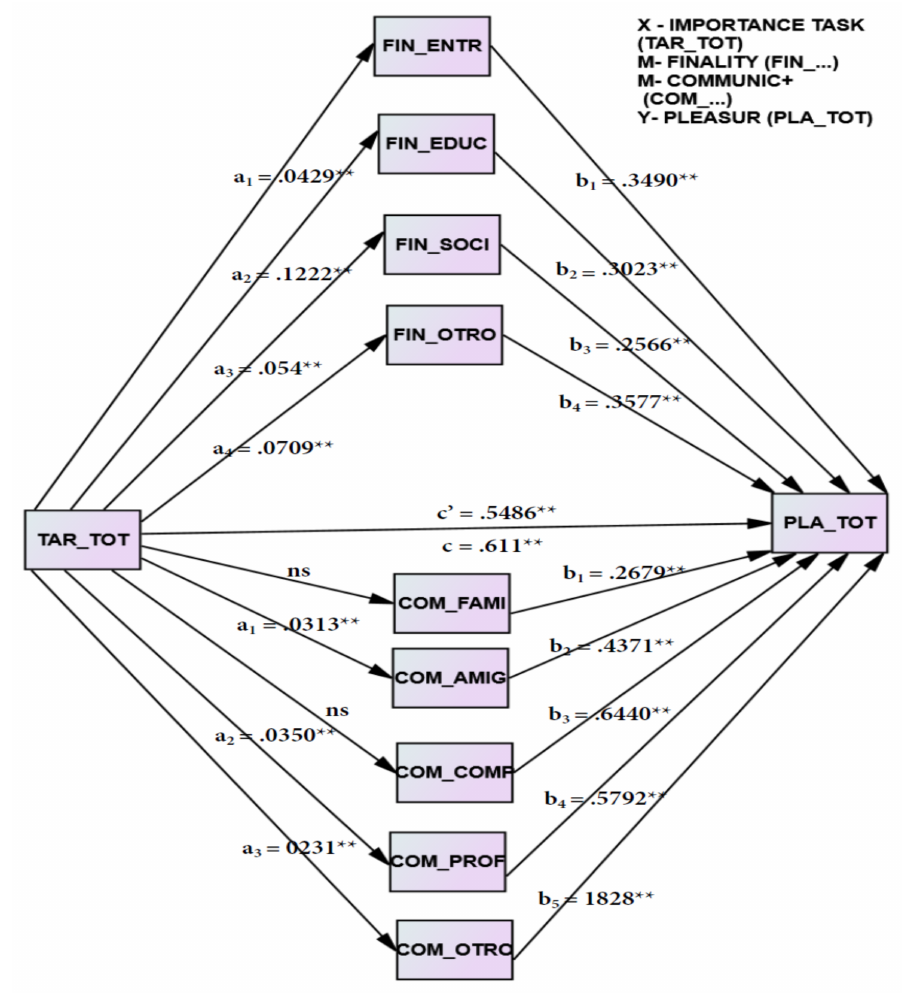
Figure 3. Mediation model of how the importance of digital task influences the satisfaction and pleasure of the use of digital technologies via finality of the tools and communication with those tools. Causal mediational analysis X → M → X, being the indirect effects of X (importance of the digital task) on outcome Y (feelings of digital activities) through the variable M (purpose and communication), a i and b i and the direct effects c (cid:48) of X over Y, with the total effects c. **: p <